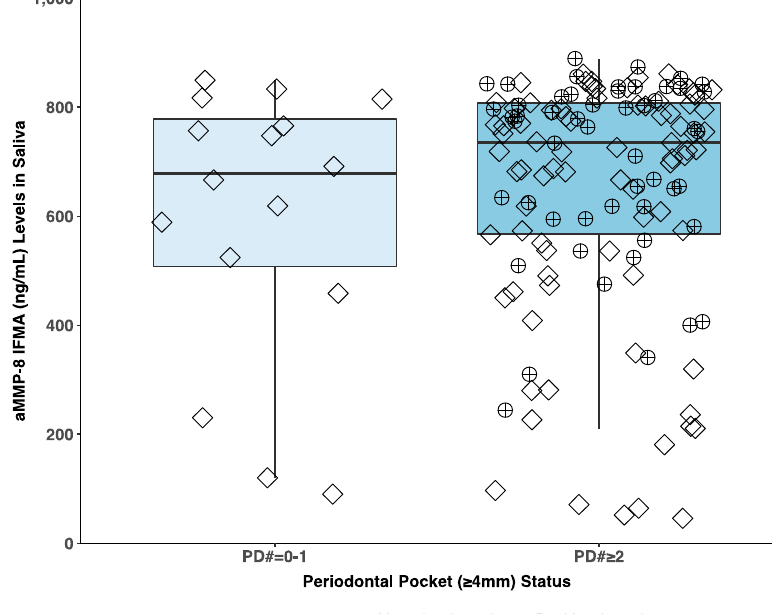
The concentrations of aMMP-8 (ng / mL) in saliva measured by time-resolved immunofluorometric assay (IFMA) according to patient’s periodontal pocket ( ≥ 4 mm) status (zero or one [PD# = 0–1] vs. two or more periodontal pockets [PD# ≥ 2]) categorized by the corresponding ORALyzer test result (cut-o ff 20 ng / mL) measured from oral mouthrinse. A positive and negative ORALyzer results marked as diamonds and circle-plusses, respectively. N = 150 Greek patients.